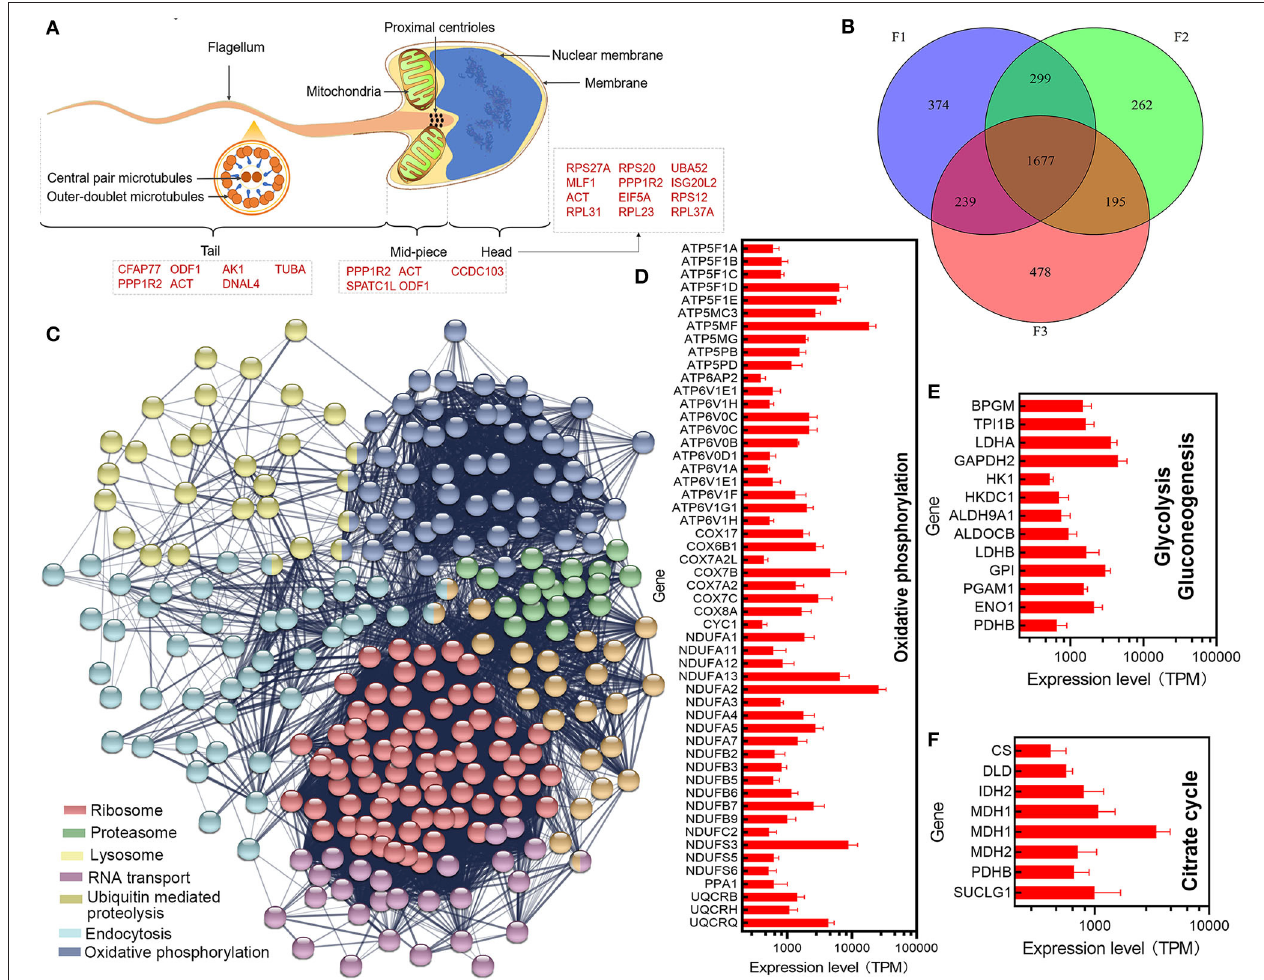
FIGURE 2 | Estimation of commonly expressed transcripts in each spermatozoon. (A) Distribution of highly expressed transcripts. (B) Intersection of commonly expressed transcripts in each sample. (C) Significant enriched pathway of commonly expressed transcripts in each spermatozoon. (D–F) Expression levels of transcripts involved in the oxidative phosphorylation, glycolysis/gluconeogenesis, and citrate cycle pathway,